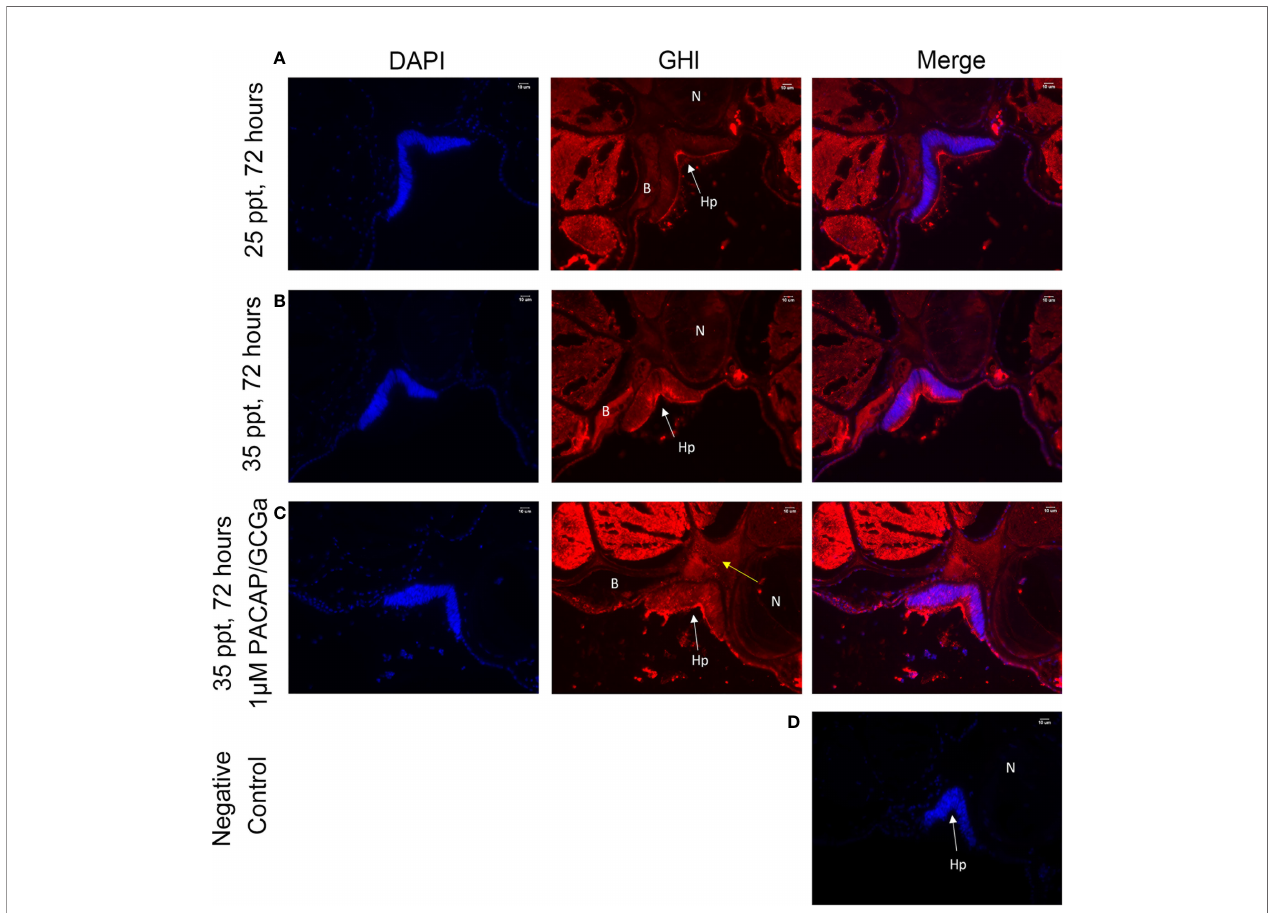
FIGURE 8 | GHl-positive signals in the B . belcheri Hatschek ’ s pit by immuno fl uorescence staining. Immuno fl uorescence digital images of DAPI staining (blue) and GHl- positive (red) signals and the merged and negative control (merged). The location of GHl in Hatschek ’ s pit was detected using a polyclonal antibody against B . belcheri GHl. Digital images of the (A) control at 25 ppt ASW (control), (B) after 72 h exposure to 35 ppt ASW, and (C) after exposure to 1 m M BfPACAP/GCGa. White arrows indicate the positively stained GHl (red) near the blood cavity, and the yellow arrows indicate the positive signals in the connective tissue (acellular) and in the blood cavity. DAPI staining is in blue. (D) Negative control. N, notochord; Hp, Hatschek ’ s pit; B, blood cavity region. The scale bar is 10 m m and is indicated in the